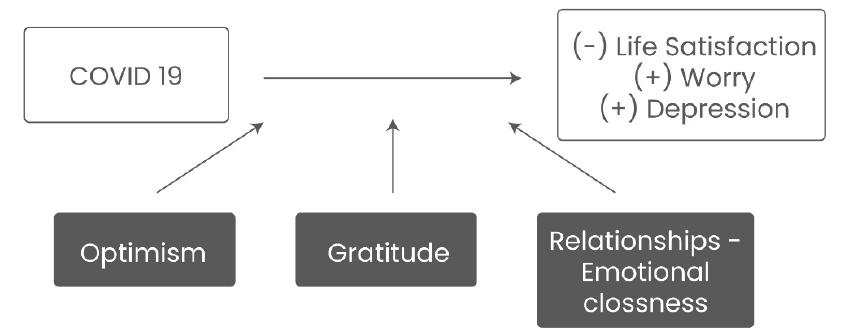
Figure 1. Analytical framework.